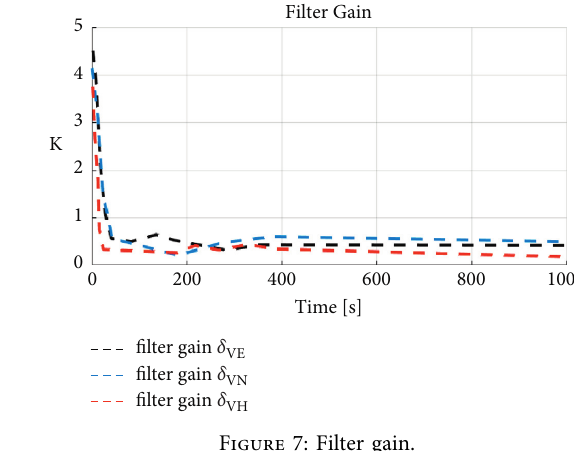
Figure 7: Filter